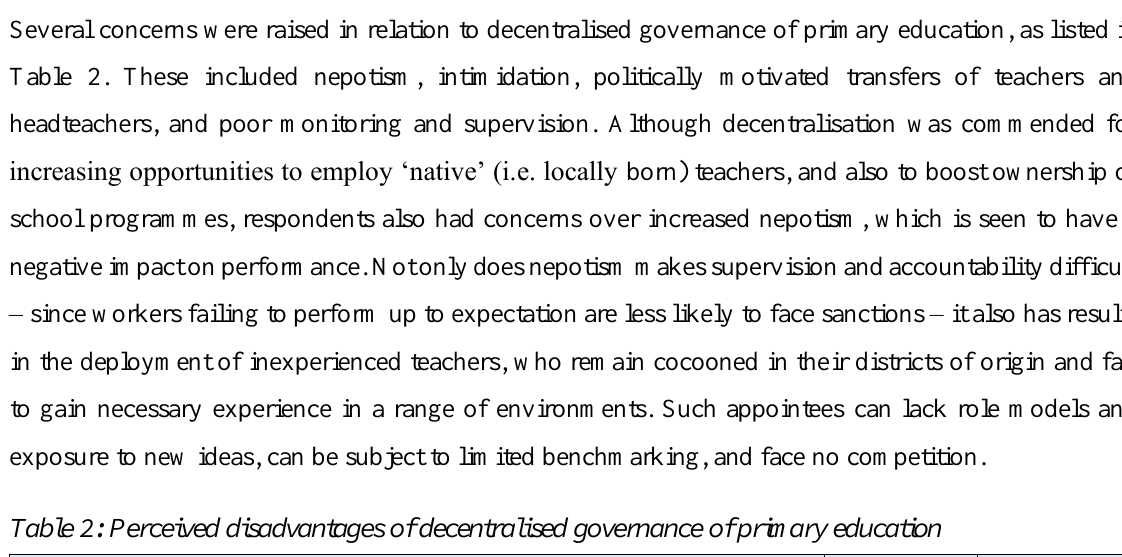
Table 2: Perceived disadvantages of decentralised governance of primary education Perceived disadvantages Number of